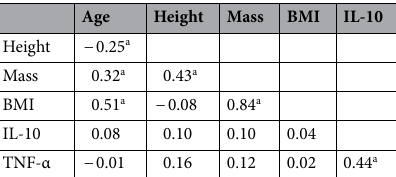
Table 3. Group correlation coefficients. a p < 0.05, n = 218; Mass, body